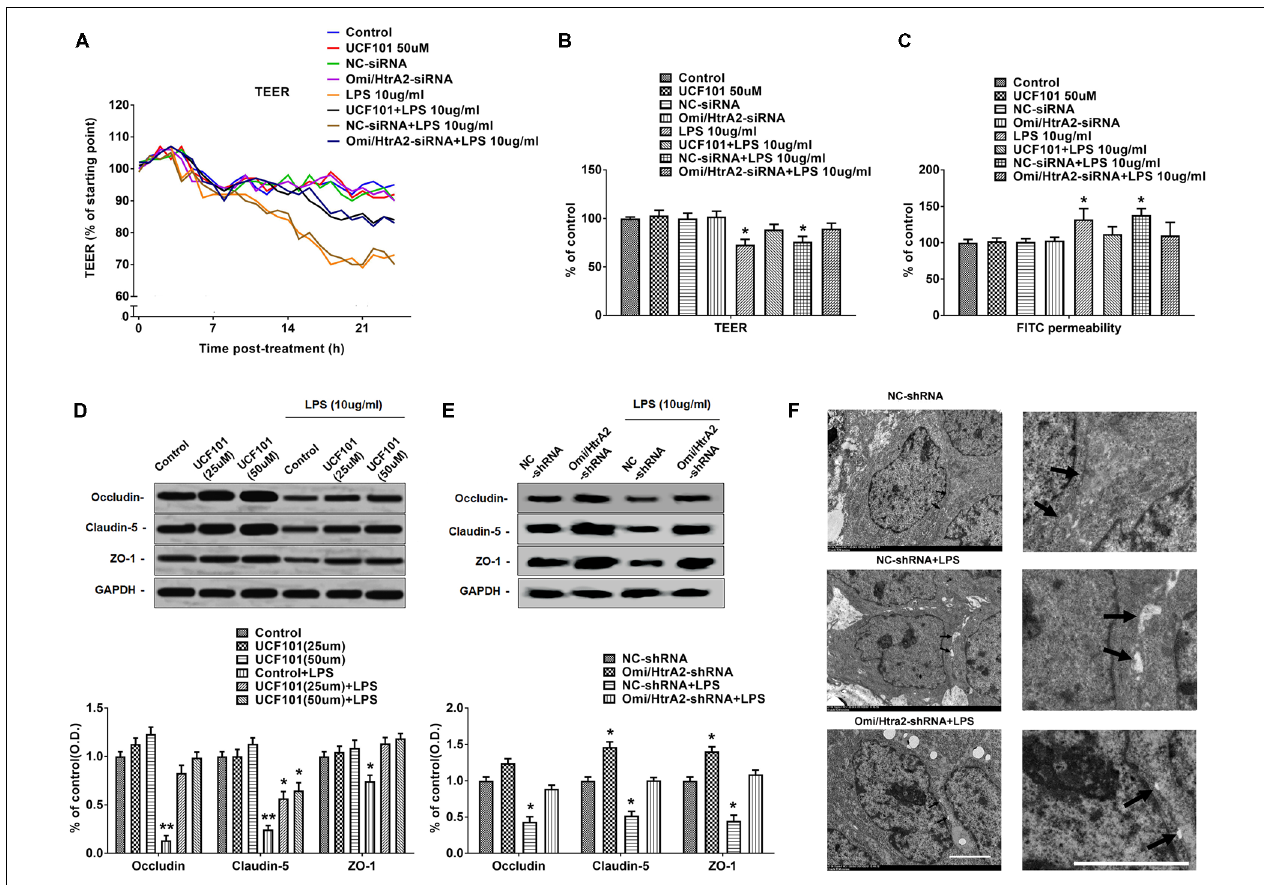
FIGURE 3 | Omi/HtrA2 regulates LPS-induced loss of brain endothelial barrier integrity and tight junction (TJ) protein expression. (A) Effects of inhibition of Omi/HtrA2 by UCF-101 or Omi/HtrA2 shRNA on TEER in LPS-treated hCMEC/D3 monolayers over a 24-h experimental period. (B) Effects of inhibition of Omi/HtrA2 by UCF-101 or Omi/HtrA2 shRNA on TEER after 18-h treatment. (C) Effects of inhibition of Omi/HtrA2 by UCF-101 or Omi/HtrA2 shRNA on paracellular permeability to FITC- (4kDa) dextrans across hCMEC/D3 monolayers after 18-h treatment. (D,E) Effects of inhibition of Omi/HtrA2 by UCF-101 or Omi/HtrA2 shRNA on occludin, claudin-5 and ZO-1 expressions as determined by western blot analyses. Respective bands with GAPDH as loading control were shown. ∗ P < 0.05, vs. control or NC-shRNA, ∗∗ P < 0.01, vs. control or NC-shRNA. (F) Effects of abrogation of Omi/HtrA2 by Omi/HtrA2 shRNA on BBB ultrastructures in LPS-treated hCMEC/D3 monolayers as determined by transmission electron microscopic (TEM). Arrows show TJ. Scale bar, 10 µ m.